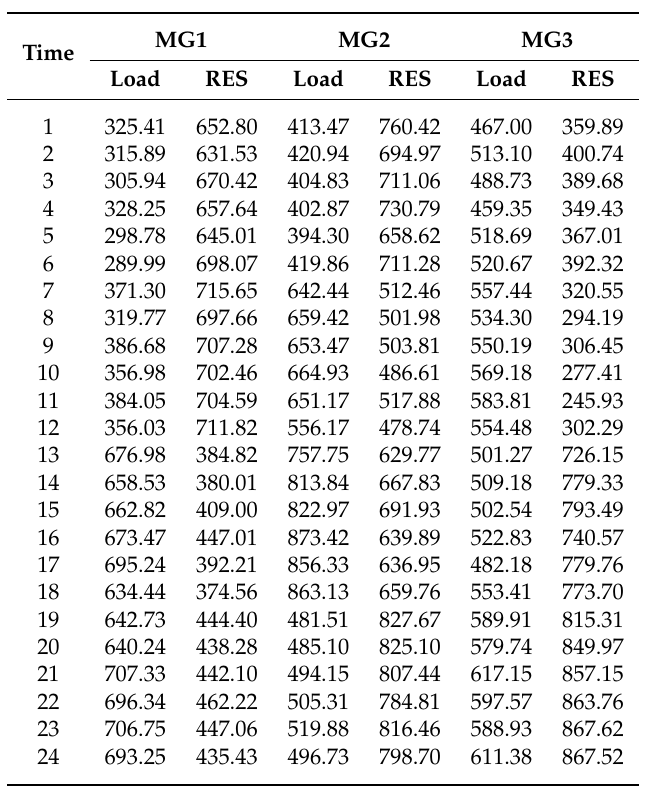
Table 2. Microgrids predicted aggregated load and RES generation [kW].